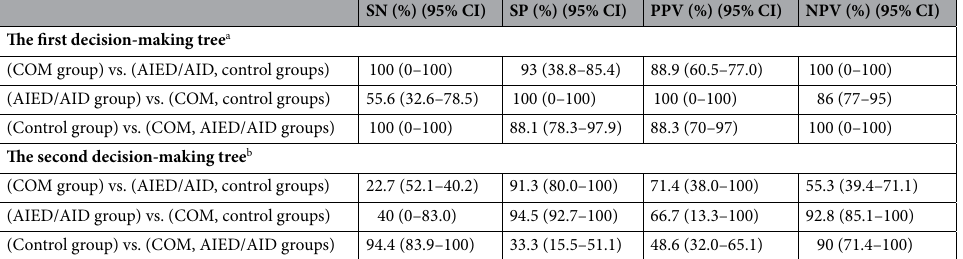
Table 2. Diagnostic performance of the two decision-making trees. SN sensitivity, SP specificity, PPV positive predictive value, NPV negative predictive value, CI confidence interval, COM chronic otitis media, AIED/ AID autoimmune/autoinflammatory inner ear disease. a The first decision-making tree used two nodes for the amount of effusion and presence of inner ear enhancement on post-contrast T1-weighted image. b The second decision-making tree used two nodes of the degree of inner ear enhancement on post-contrast fluid-attenuated inversion recovery image.